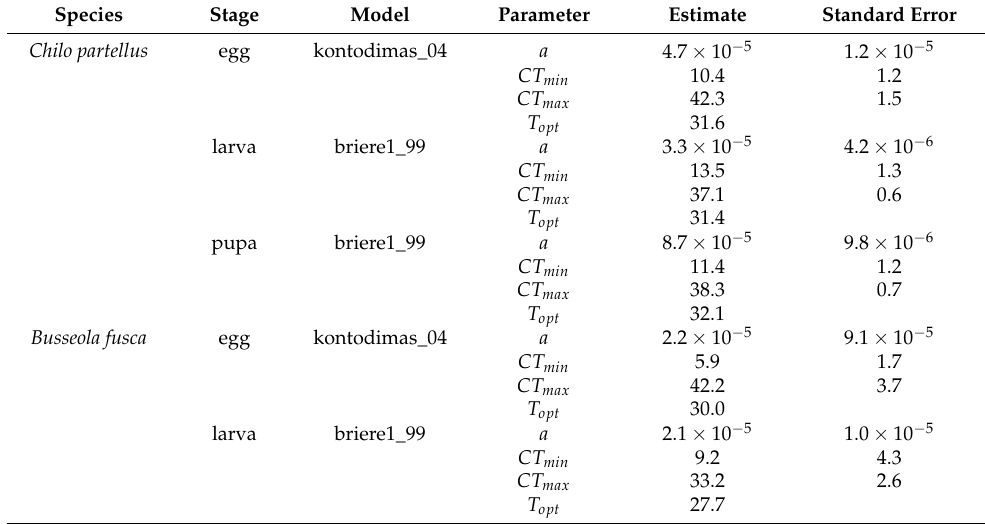
Table 3. Selected model for each life stage of Chilo partellus , Busseola fusca , Ostrinia nubilalis and Sesamia nonagrioides , and their estimated parameter values with standard errors. For all models, T opt was esti- mated as the local maximum between CT min and CT max for models impeding analytical